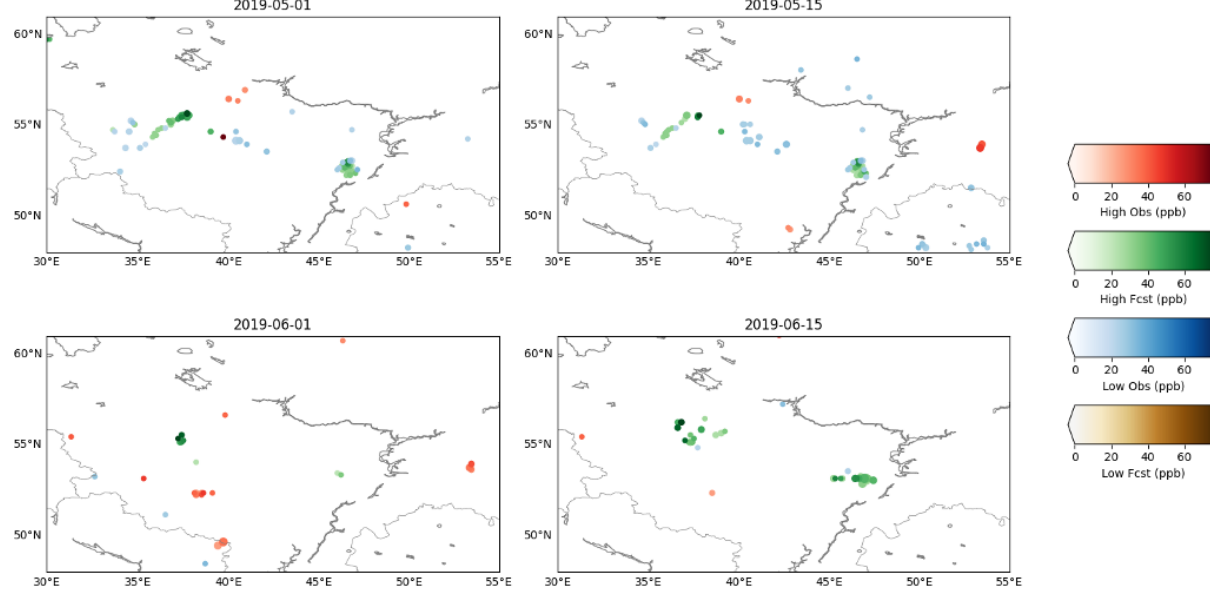
Figure 12. Outlier detection and classification over western Russia. Dates indicate the end date of the 30d time window.